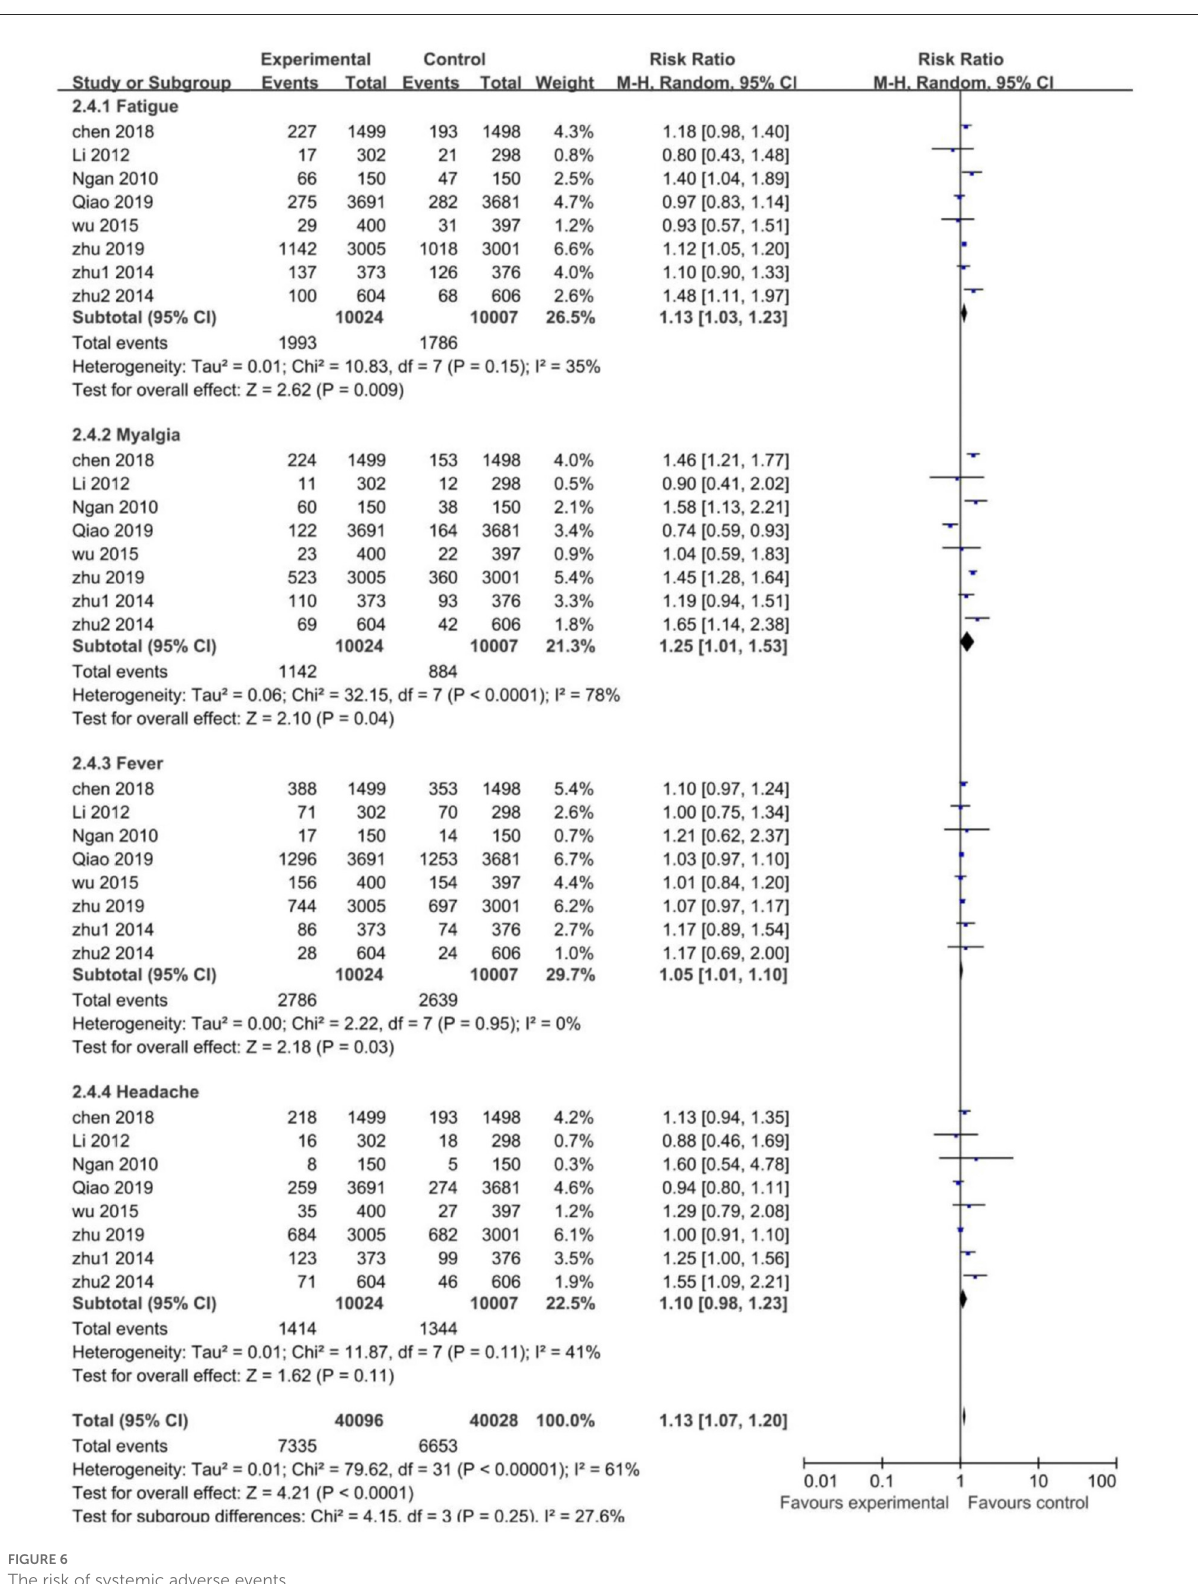
FIGURE6 The risk of systemic adverse